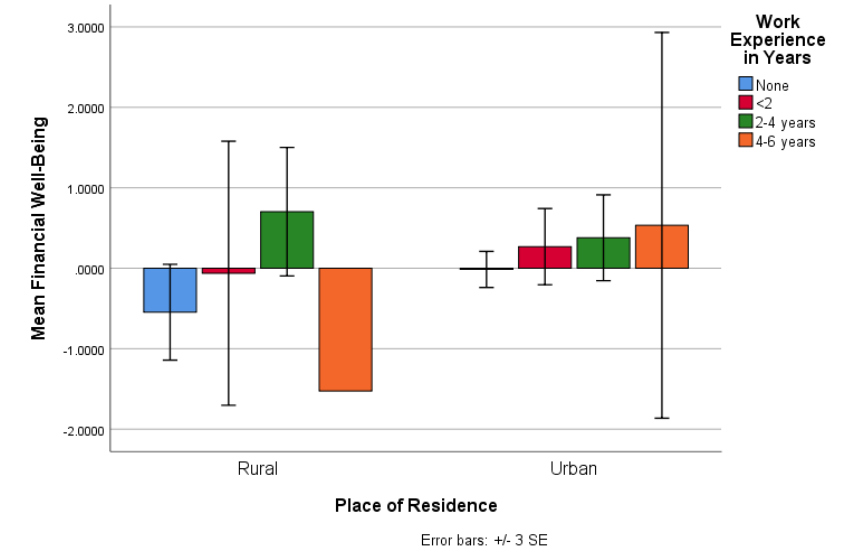
Figure 5. Distribution of financial well-being scores by place of residence and work experience